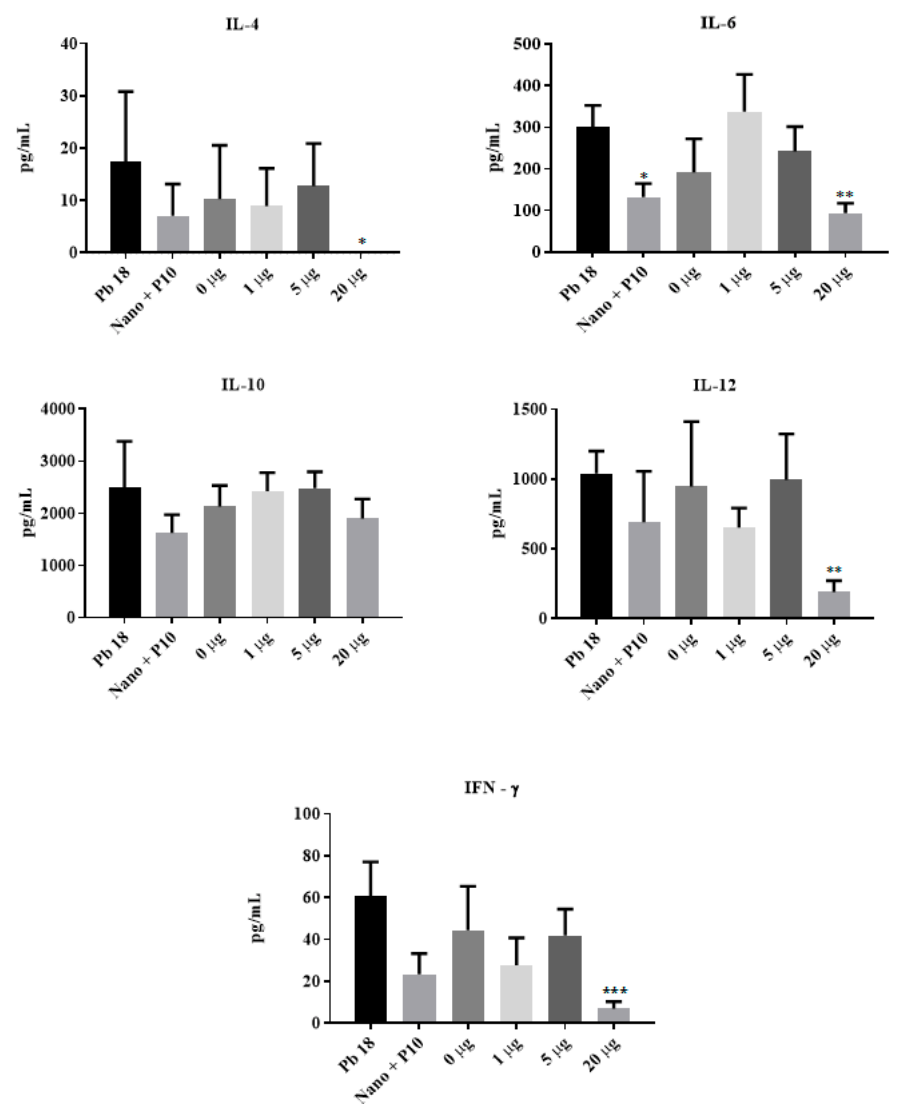
Figure 4. Determination of cytokine production in lung homogenat of BALB / c mice after 51 days of infection with P. brasiliensis. Mice were infected and randomly distributed in the following groups: Pb 18: non-treated; Nano + P10: co-administered vaccine (empty nanoparticles + 20 μ g/10 μ L free-